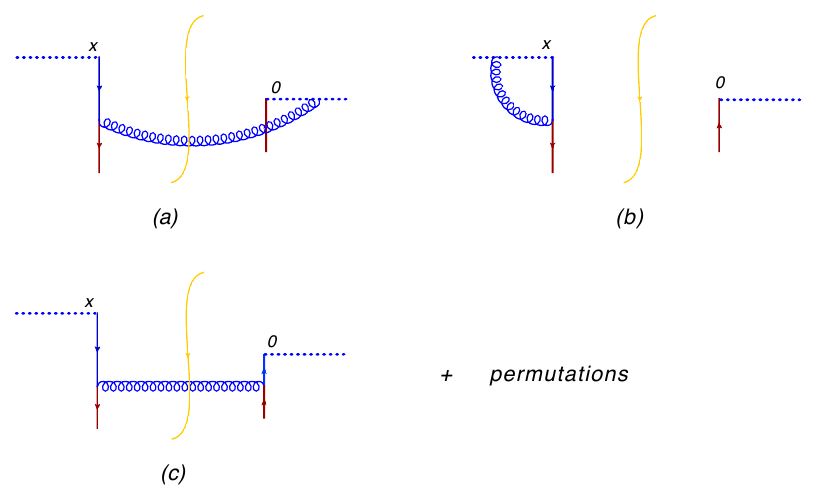
Figure 3 . Typical diagrams for the rapidity evolution of quark TMD in the Sudakov